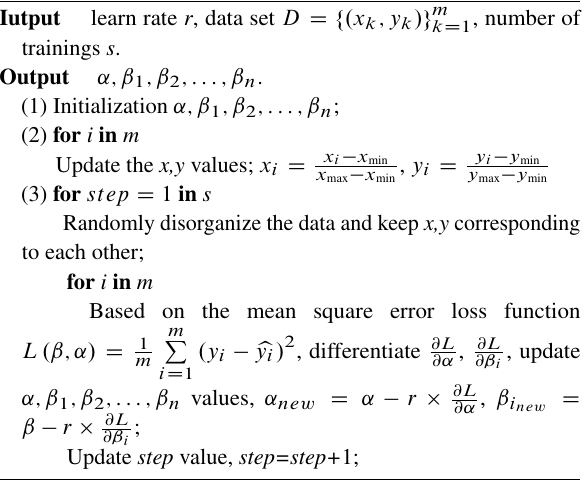
Algorithm 1 Stochastic gradient descent algorithm Iutput